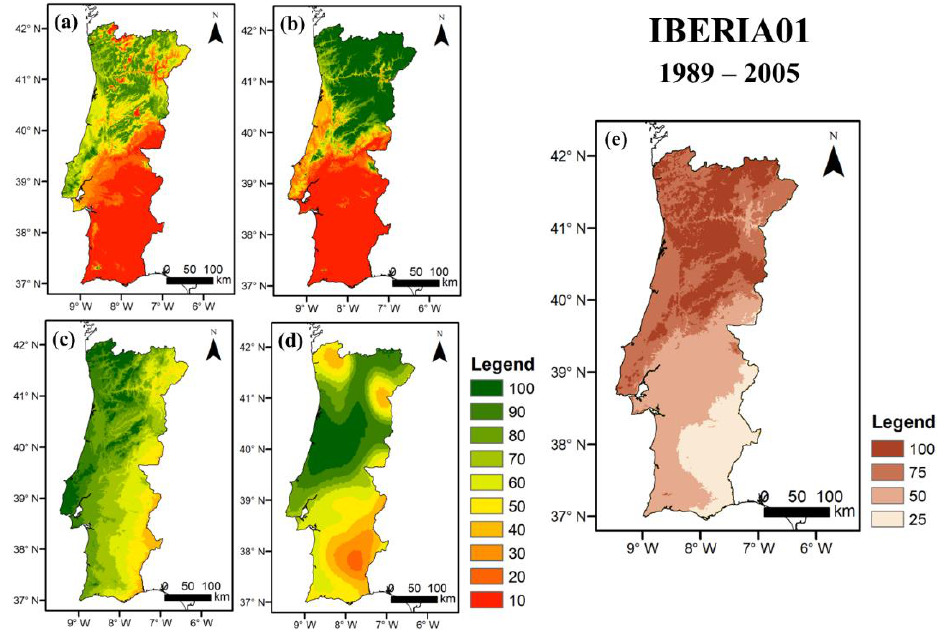
Figure 3. Mean percentage of occurrence of ( a ) growing degrees days between 1900 and 2400 °C, ( b ) annual mean temperature between 8 and 15 °C, ( c ) summer days with maximum temperature below 32 °C, ( d ) annual accumulated precipitation between 600 and 1600 mm, and ( e ) chestnut suitability index, for the baseline (IBERIA01; 1989 – 2005) period.